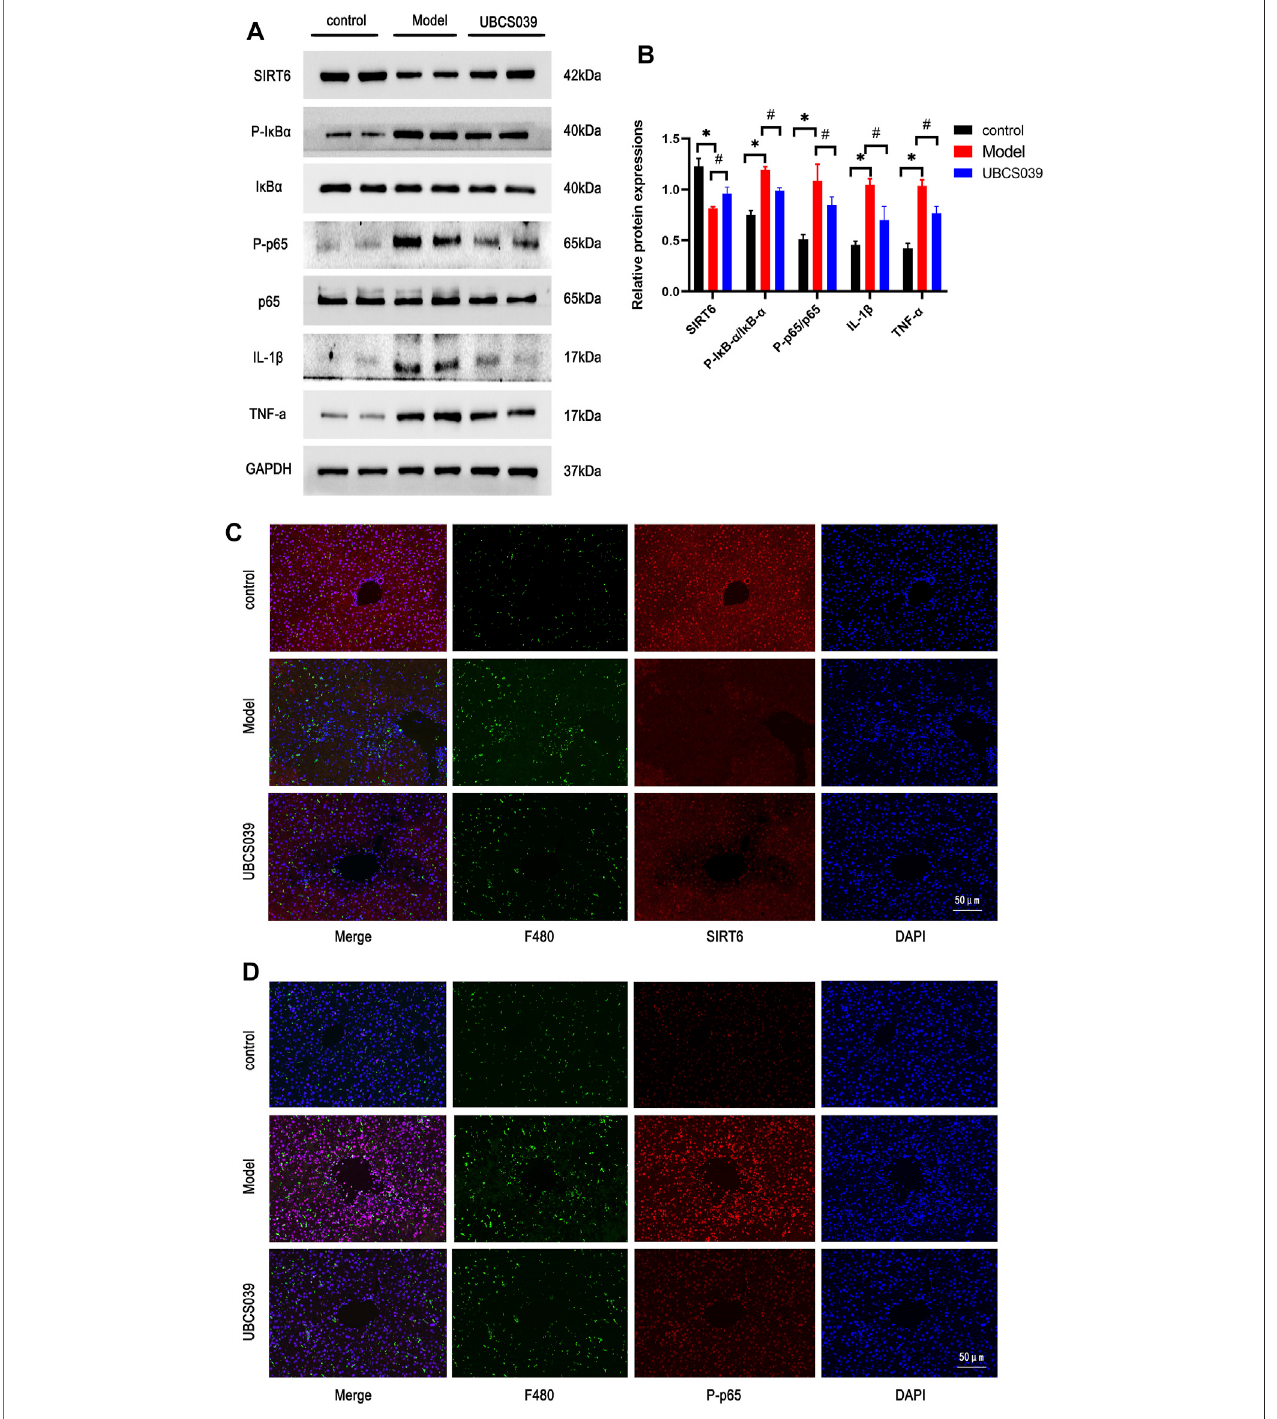
FIGURE3| EffectsofUBCS039ontheNF- κ Bpathwayinlivertissues. (A) WesternblottingwasusedtoanalyzetheexpressionsofSIRT6,P-p65,p65,p-IKBa,IKBa,IL-1 β , and TNF- α in the liver sample. (B) Densitometric analysis of relative proteins. (C) Immuno fl uorescent staining of liver sections with anti-F480 (green) and anti-SIRT6 (red). (D) Immuno fl uorescentstainingofliversectionswithanti-F480(green)andanti-P-p65(red).* p < 0.05,comparedwiththecontrolgroup.# p < 0.05,comparedwiththemodelgroup. n = 5 per group. Data are represented as mean ± SD.